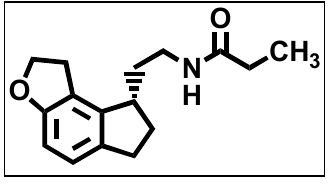
Figure 4. Structure of compound C (Rozerem) Source: Uchikawa and Okawa